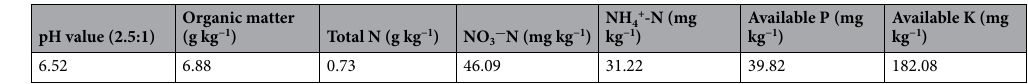
Table 9. Part properties of tested soil before ryegrass planting in